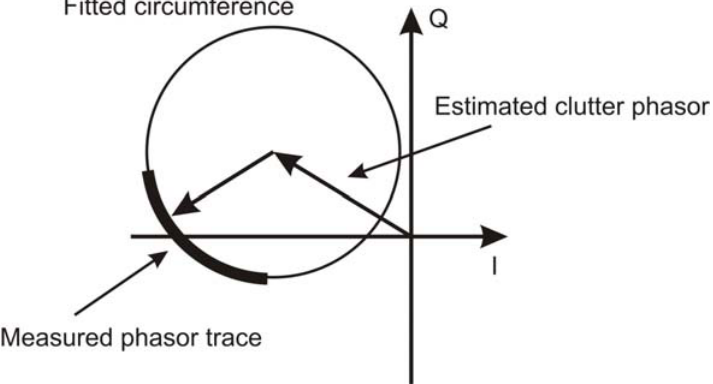
Figure 1. Phasor trace in I-Q plane due to static clutter and a rigid shift of a